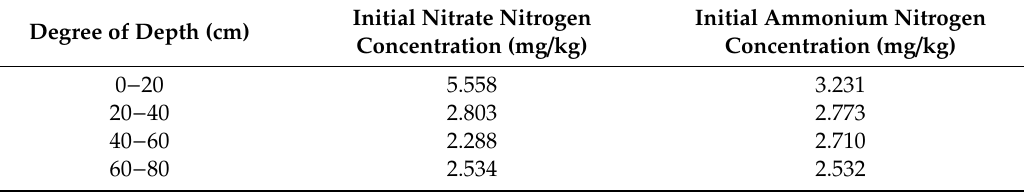
Table 1. Initial nutrient status of